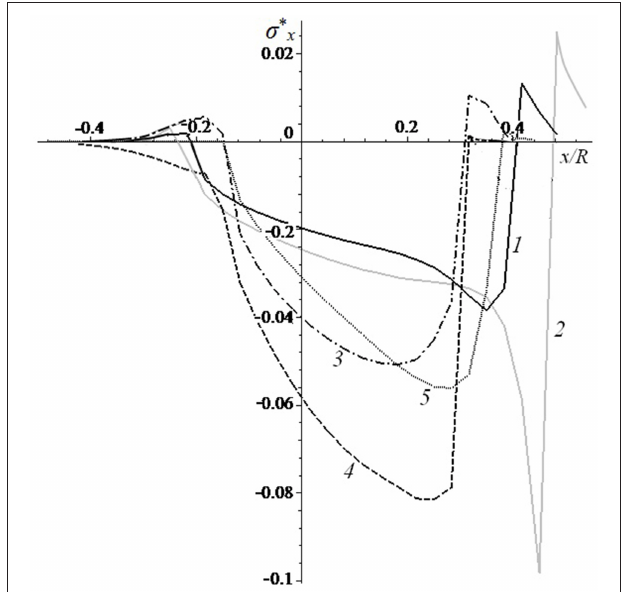
FIGURE 8 | Surface tensile-compressive st c = 5ress distribution [ V ∗ = 0.333 (curves 1,2,4,5), V ∗ = 1.666 (curve 3); c = 5 (curves 1, 3-5), c = 20 (curve 2);